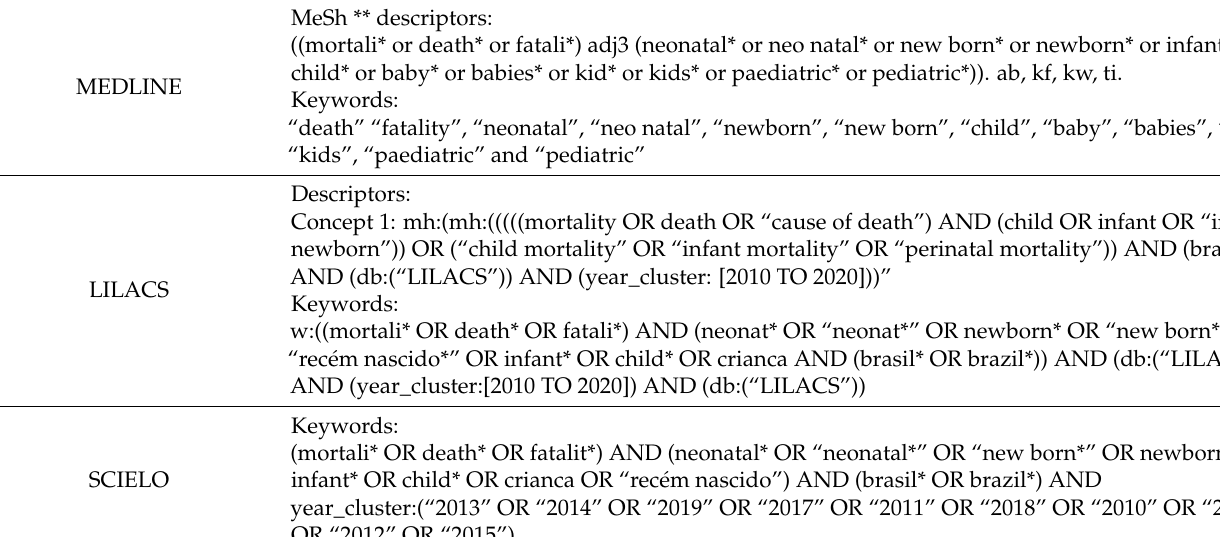
Table 1. Descriptors and keywords used according to database †